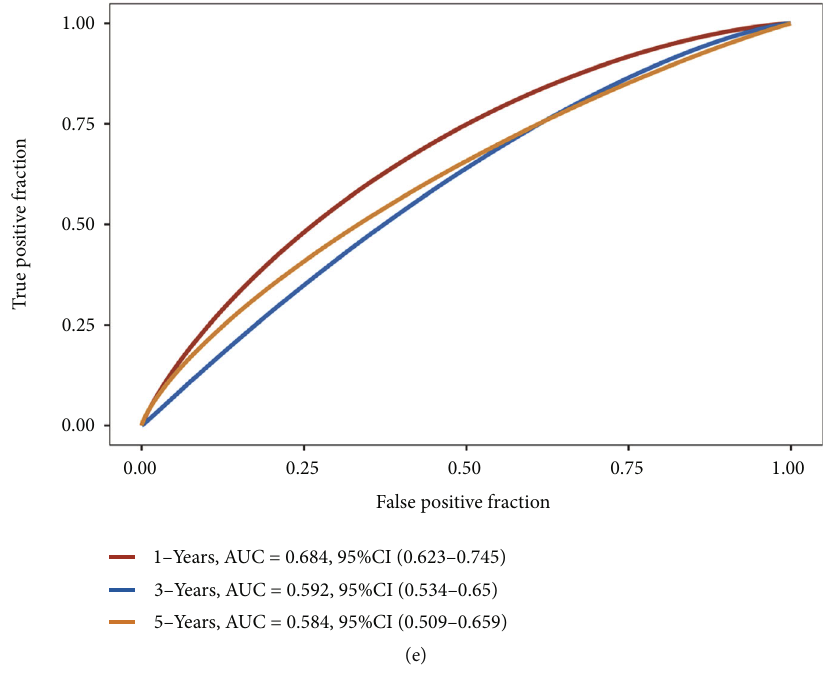
Figure 4: Construction of a necroptosis-related prognostic gene signature. (a), and (b) The coe ffi cient and partial likelihood deviance of prognostic signature. (c) Risk score distribution survival status of patients and gene expression in prognostic signature. (d) and (e) Overall survival curve in patients with high/low risk and the ROC curve evaluated the predictive signi fi cance in 1-year, 3-year, and 5- year of LUAD